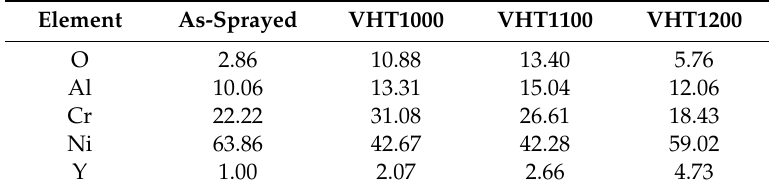
Table 6. Analysis of element components on the surfaces of the as-sprayed coating and VHT coatings